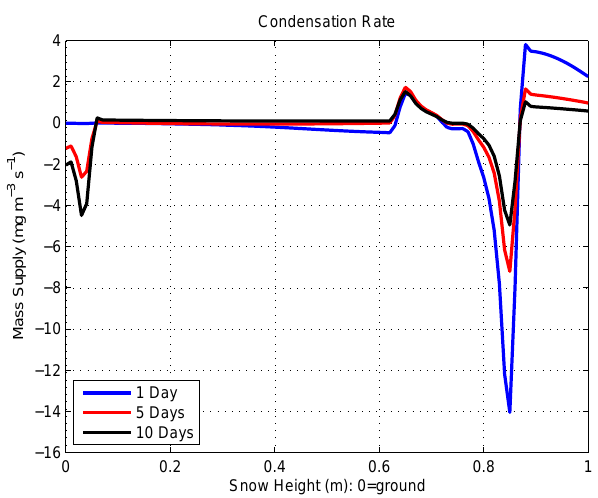
Figure 12. Snowpack condensation rates at 1, 5, and 10 days, re- spectively. Positive values indicate condensation while negative val- ues indicate